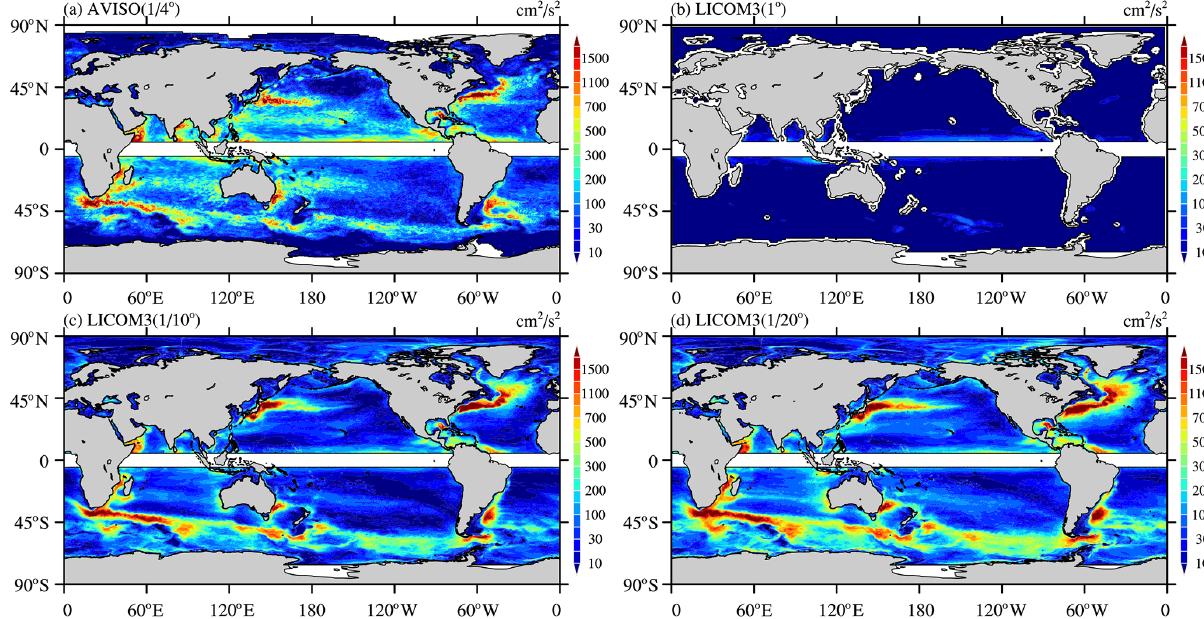
Figure 15. (a) Observed annual mean eddy kinetic energy (EKE) in 2016 from AVISO (Archiving, Validation and Interpretation of Satellite Oceanographic). Simulated annual mean SST in 2016 for LICOM3-HIP at (b) 1 ◦ , (c) 1 / 10 ◦ , and (d) 1 / 20 ◦ . Units: cm 2 s − 2 . Table 4. Some GPU versions of weather/climate models. Model Language Max. grids